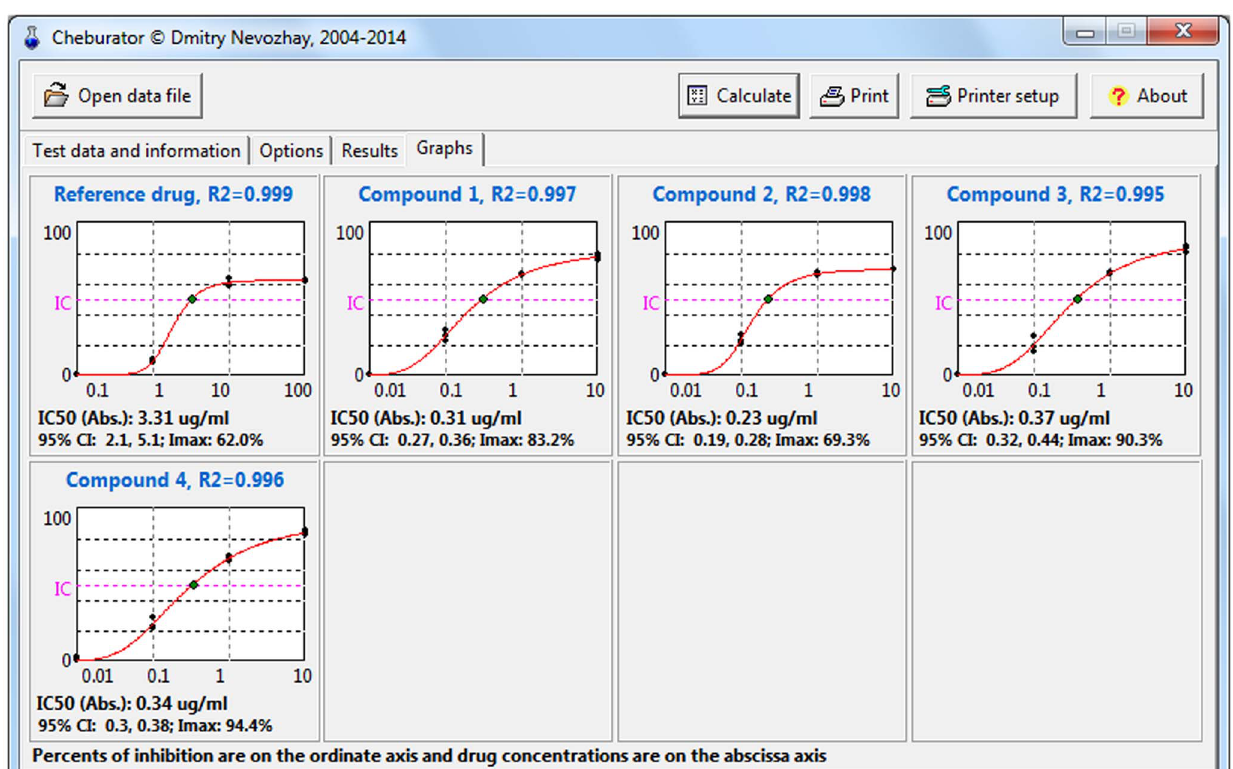
Figure 8. The Graphs tab after the analysis. It is showing the dose-response curves, individual values of percentages of inhibition for each data point, method of calculation used, IC 50 values, its type, 95% confidence intervals, and goodness of fit (for regression analysis).